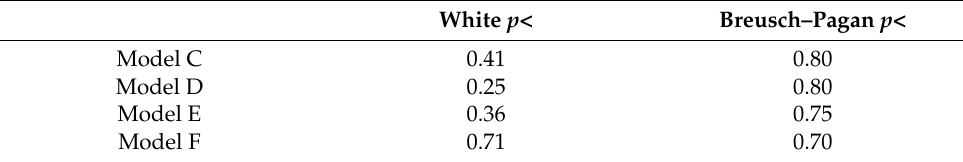
Table 1. Results of tests of homoscedasticity for models